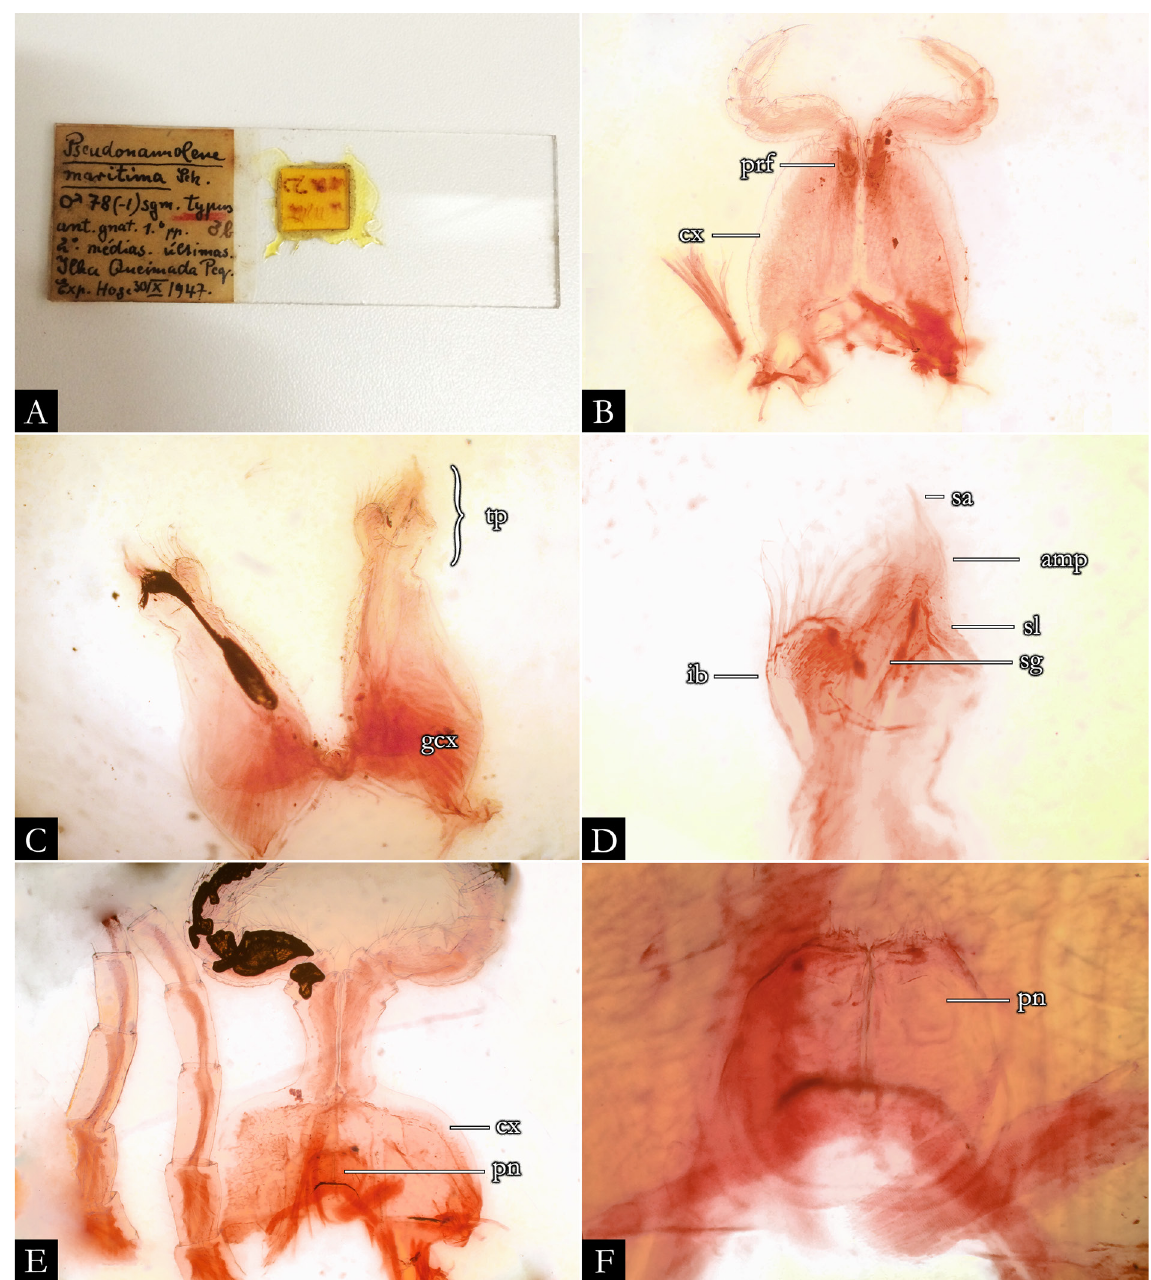
Fig. 91. Pseudonannolene maritima Schubart, 1949, holotype, ♂ (MZSP). A . Sexual structures, antennae, and gnathochilarium of type material mounted on microscope slide. B . First leg-pair. C . Gonopods, in oral view. D . Detail of telopodites, in oral view. E . Second leg-pair. F . Detail of penis. Abbreviations: see Material and methods. Images not to